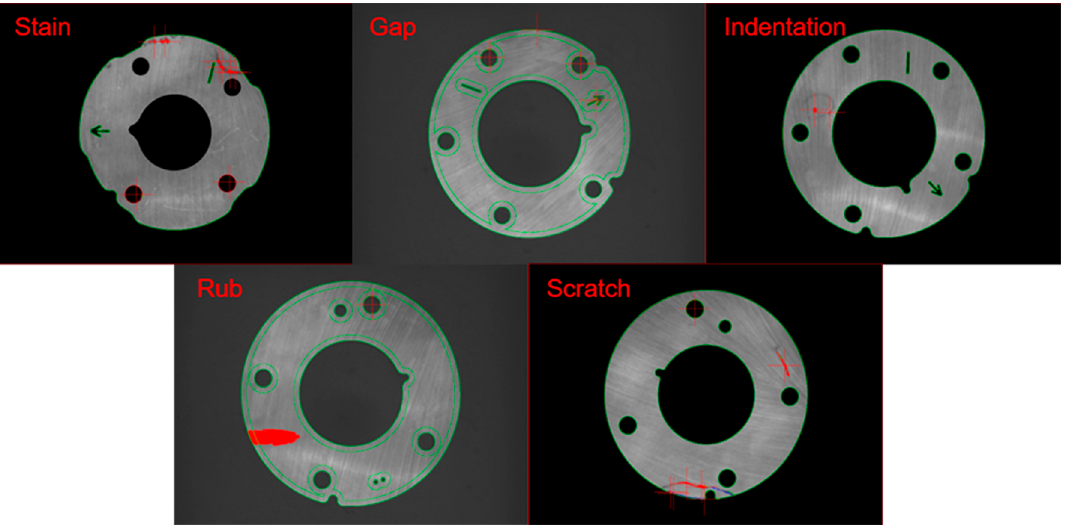
Figure 14. Defects detection for the parts.